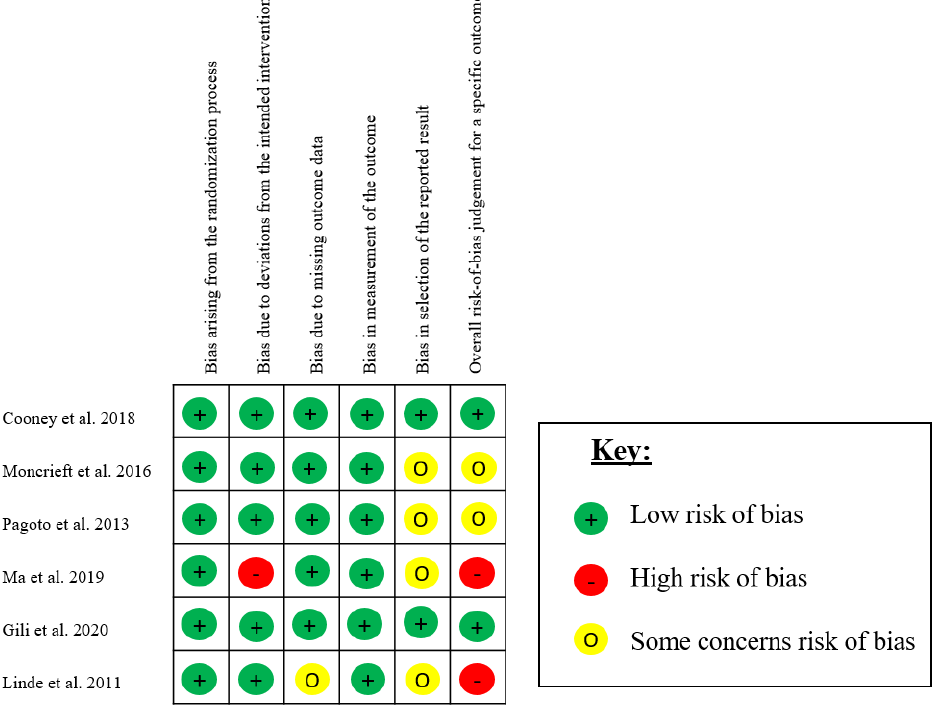
Figure 2. Risk of bias of included studies.